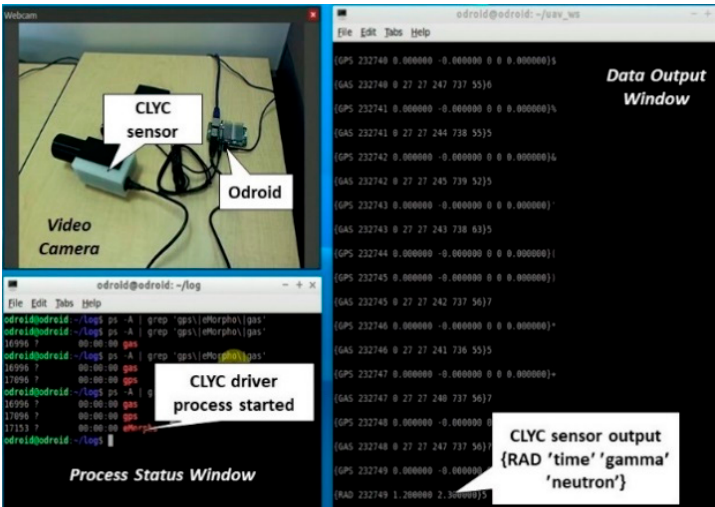
Figure 5. Scheme of “plug and fly” operation of the CLYC sensor.